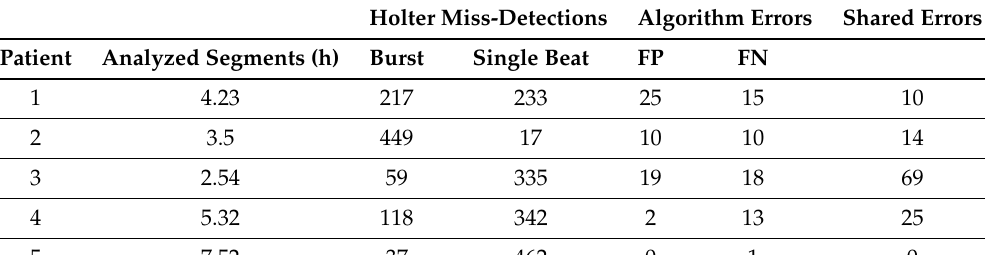
Table 10. Results of analyzing the first 500 errors in the worst day of the LTM recordings in PREMARIS database.